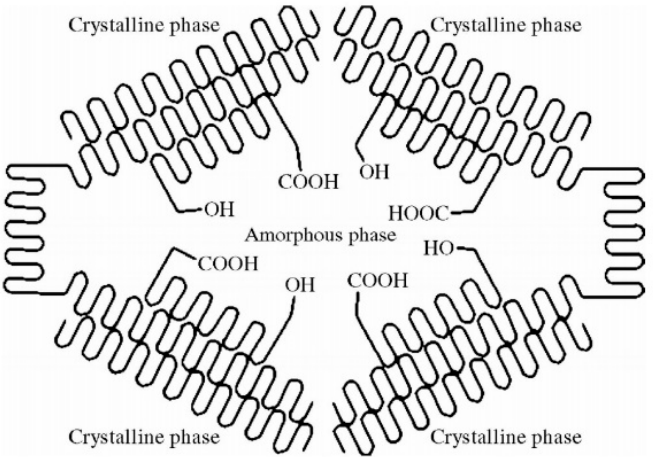
Figure 10. Schematic depiction of solid-state polycondensation.